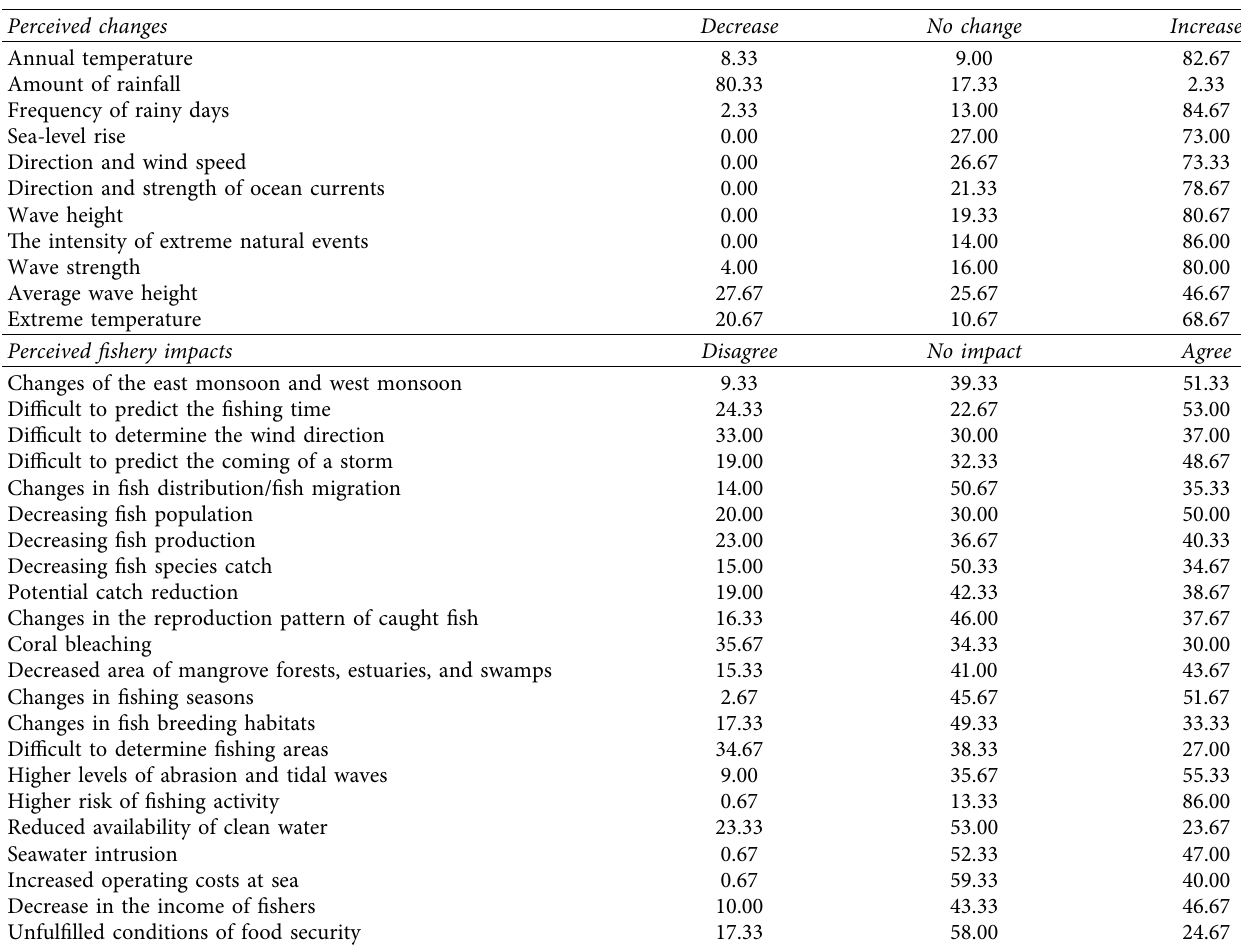
Table 6: Perceived changes in the climate and within the fsheries ( n �